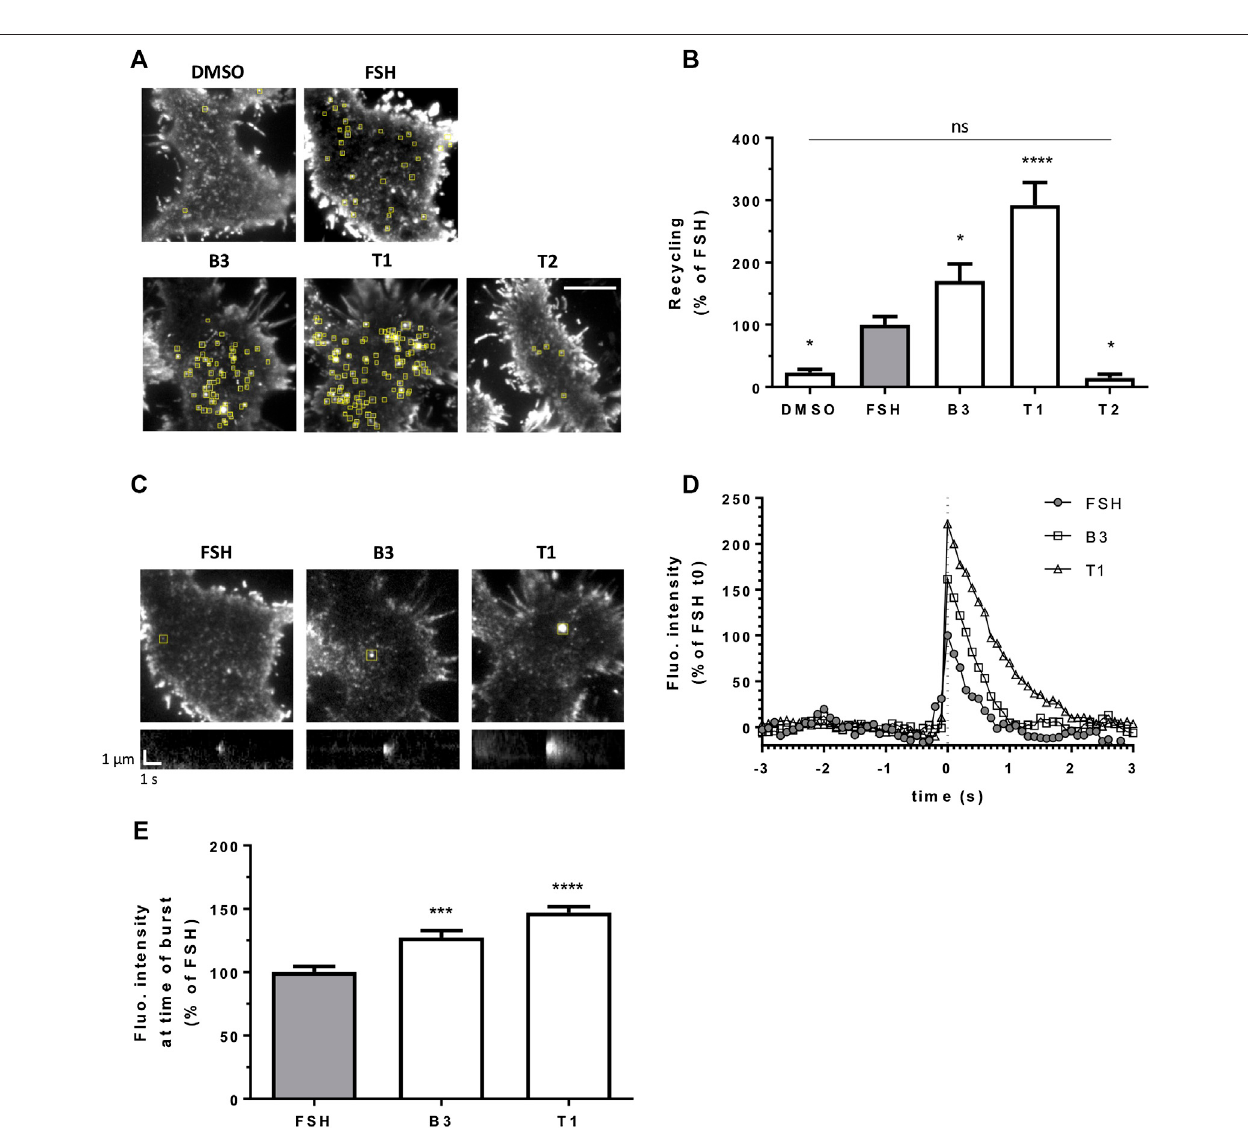
FIGURE3| LMWagonistsofFSHRinduceagreaterexocyticratethanFSH. (A) MaximumintensityprojectionsfromSEP-FSHR expressingHEK293cellsimaged live by TIR-FM before and after 5-min stimulation with either DMSO, FSH (10 nM), B3, T1 or T2 (10 μ M). Yellow squares indicate exocytic events detected in the correspondingTIR-FMmovies( Supplementary MoviesS1 – S5 ).Scalebar (cid:2) 10 μ m. (B) Quanti fi cationofthenumberofFSHRexocyticeventsfrom (A) ;n (cid:2) 7 – 11cells/ condition collected across at least three independent experiments. One-way ANOVA: * p < 0.05, **** p < 0.0001. (C) Images (top) and kymographs (bottom) of representative FSHR exocytic events (yellow squares) detected after 5-min stimulation with either FSH (10 nM), B3 or T1 (10 μ M). (D) Fluorescence intensity of the representativeFSHRexocyticeventsshownin (C) .Datarepresentaverage fl uorescencevalueswithinanROIdrawnaroundeacheventmeasured3 s(30frames)before andaftereventburst(t0)minusbackground fl uorescence( (cid:2) fl uorescencemeasuredintheROIduringthe30framesbeforeeventburst(t0)wasaveragedandsubtracted from fl uorescencevaluesat each frame); valueswerenormalized consideringFSH fl uorescence att0 (cid:2) 100%. (E) Fluorescenceintensityattimeofburstofn (cid:2) 212,326, and328exocyticeventsfrom11,9and9cellstreatedwithFSH,B3andT1,respectively,from (B) ;valuesrepresentmaximumintensity fl uorescenceminusbackground fl uorescence in each ROI at time of event burst; values were normalized considering FSH (cid:2) 100%; Kruskal-Wallis test: *** p < 0.001, **** p < 0.0001.